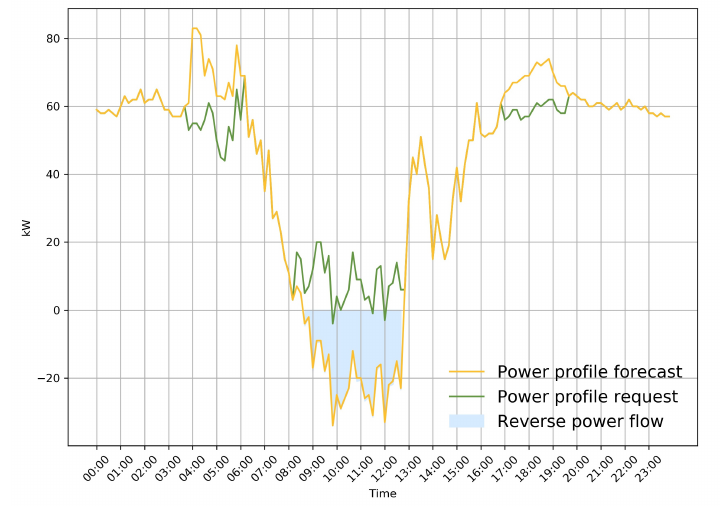
Figure 10. This figure shows a possible scenario for flexibility provisioning.